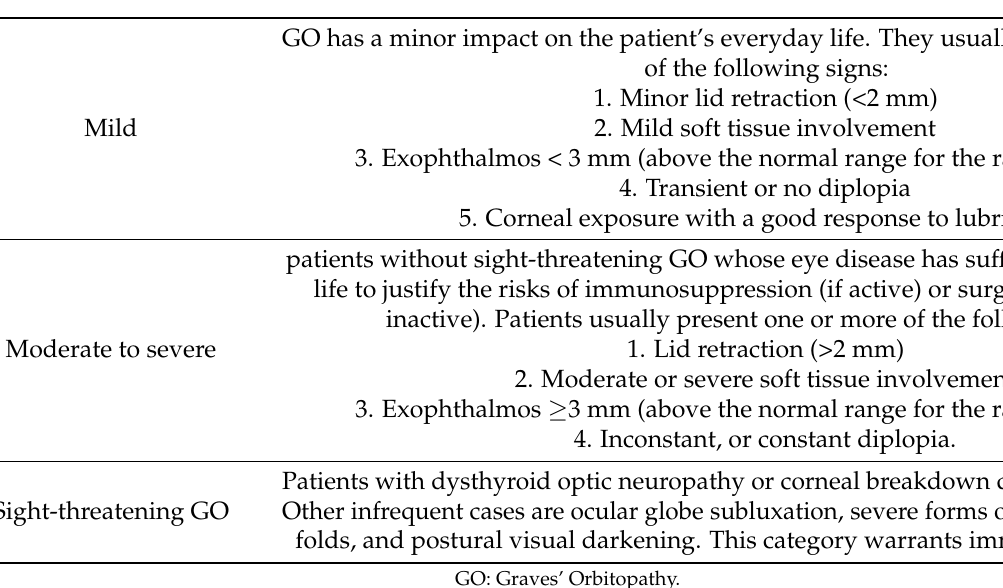
Figure 4. Transverse magnetic resonance imaging (MRI) image of the orbits of a 60 years old fe- male patient with active GO, in whom the orbital changes were asymmetrical—the left orbit was more involved. The examination was performed in T1 and T2 sequences. The left inferior rectus muscle is significantly edematous, the left medial and lateral rectus muscle and the right inferior rectus muscle are also slightly edematous— the picture indicates active inflammatory orbital changes in the course of the underlying disease. Moreover, there is exophthalmos of the left eye- ball and a slightly increased amount of the fluid in the left optic nerve sheath compared to the right side. There are no deviations of the lacrimal glands or the extra-conial adipose tissue. Though not accurate in defining the activity of the orbitopathy and the edema of soft tissues and muscles, computed tomography (CT) is a modality of choice due to its precise imaging of bone structures before planning orbital decompression in the inactive phase of GO, to navigate during the surgery and as a follow-up assessment after decompression. However, despite the short duration of the examination and precise evaluation of bone structures, the use of CT is limited also due to the radiation exposure [47].